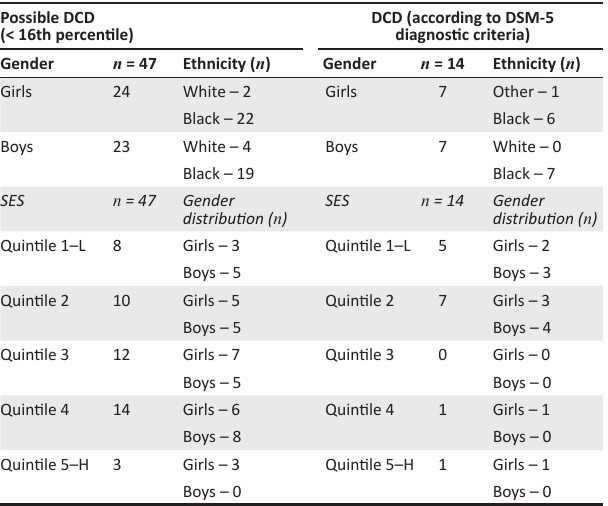
Table 2 reflects the distribution of boys and girls with DCD according to ethnicity and socio-economic status when classified with DCD using the DSM-5 diagnostic criteria ( n = 14) and those classified achieving lower than the 16th percentile ( n = 47).